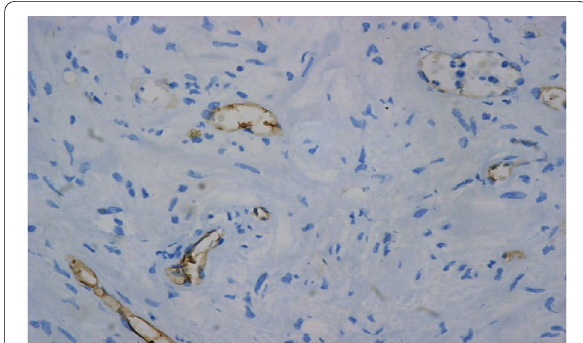
Fig. 3 CD34 staining of prostatic tissue in one patient in CPA group: showing marked decrease in microvessel density